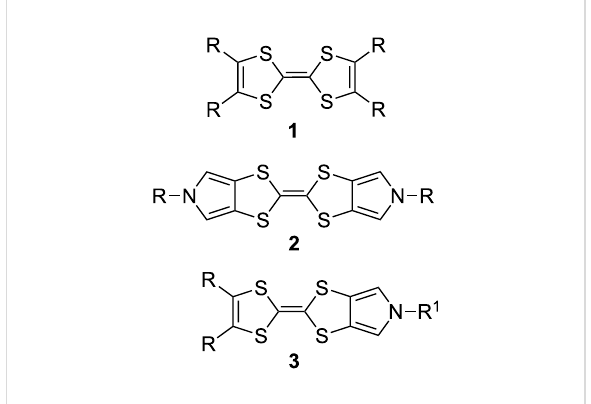
Figure 1: Molecular structures of tetrathiafulvalenes 1 , bis-pyrrolotetra- thiafulvalenes 2 and monopyrrolotetrathiafulvalenes 3 .